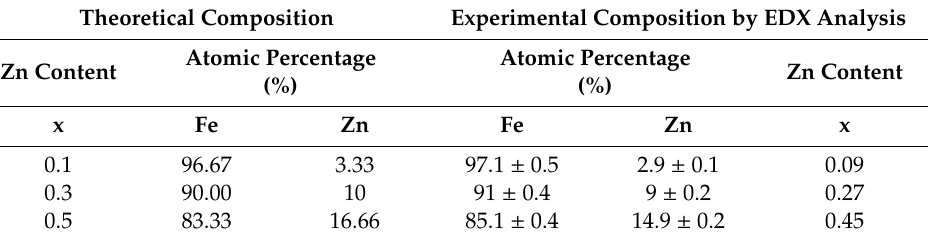
Table 2. Structural properties of Zn x Fe 3 − x O 4 MNPs.